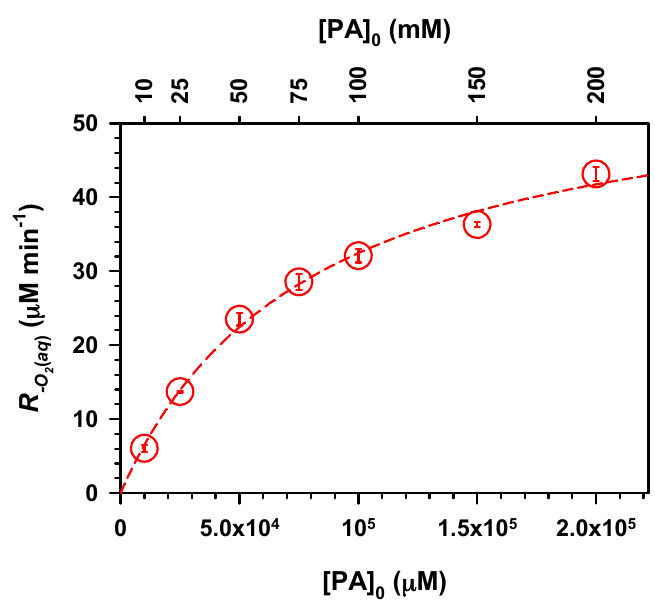
Figure 2. Rate of dissolved oxygen decay ( R − O during irradiation of solutions at pH 1.0 and 25 ◦ C under continuous air sparging at a flow rate of